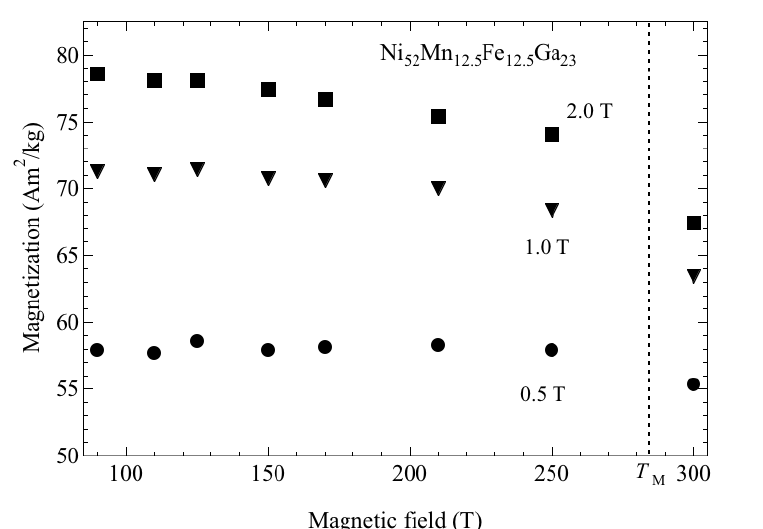
Mn Fe Ga . 52 12.5 12.5 23